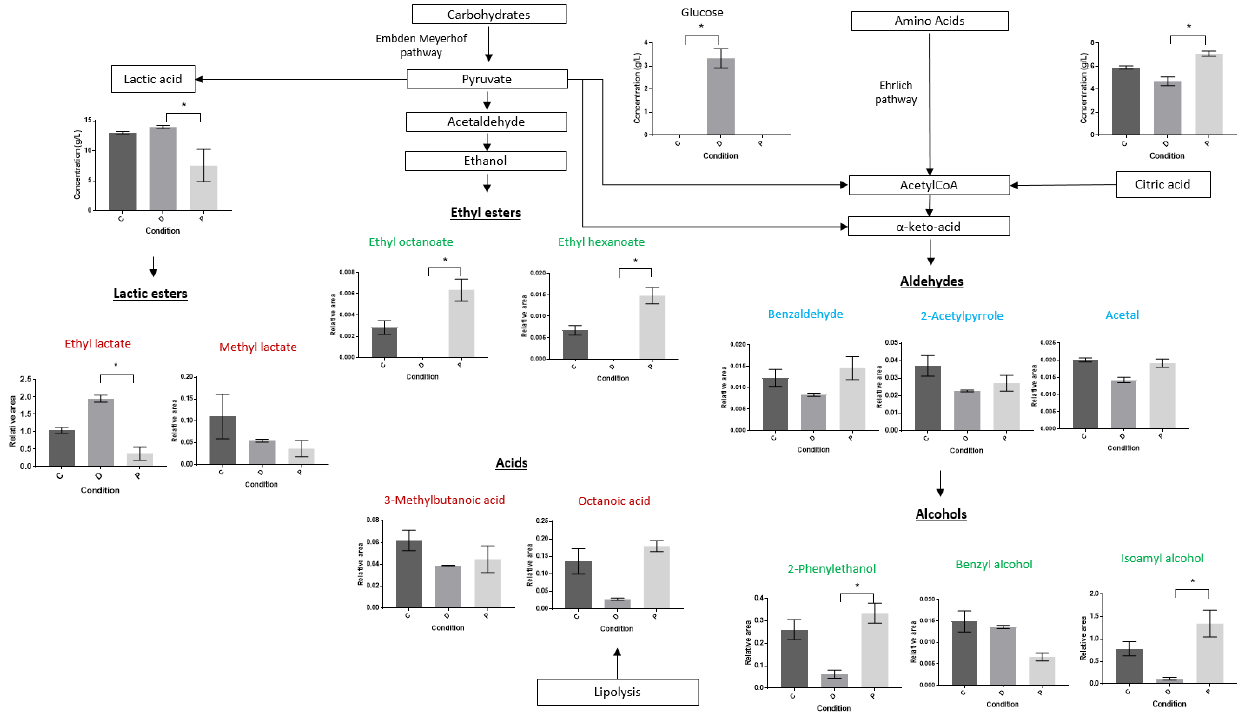
Figure 4. Principal compounds and hypothetical representation of the metabolic pathways potentially involved in the production/consumption of these compounds at 25 °C between conditions C, D and P at 168 h. Green compounds were principally associated to yeast activity, red compounds to LAB activity and blue compounds to yeast and/or LAB activity. Concentrations of lactic acid and citric acid were determined by HPLC and expressed in g/L. The volatile compounds were analyzed by GC-MS and expressed with relative area (standardized with internal standards). A Kruskal–Wallis test was performed for each compound, and multiple comparisons were performed using Dunn’s procedure. A p -value of ≤ 0.05 was considered significant (*).